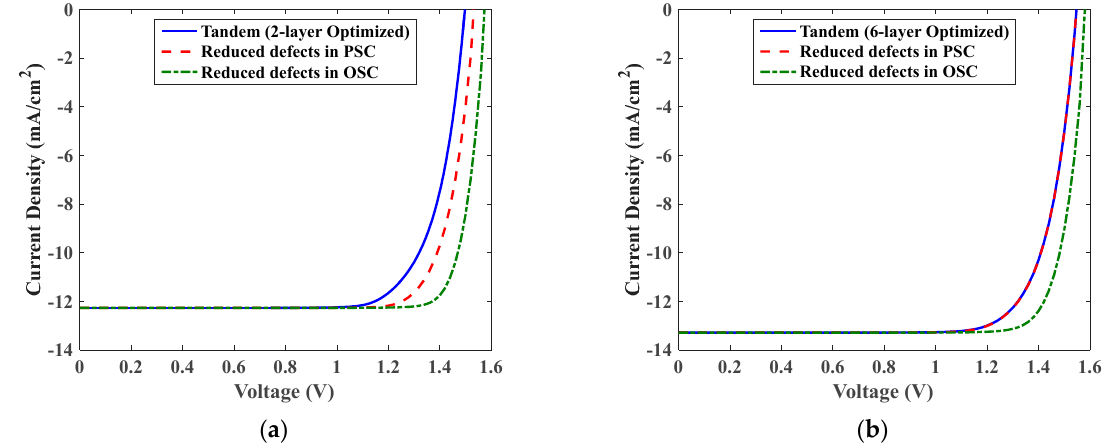
Figure 11. The illuminated J-V curves when modifying the defects in PSC and OSC for ( a ) 2-layer optimization and ( b ) 6-layer optimization. Table 3. Key tandem factors based on full optoelectronic optimization for 2-layer and 6-layer opti- mization under various situations of defects.